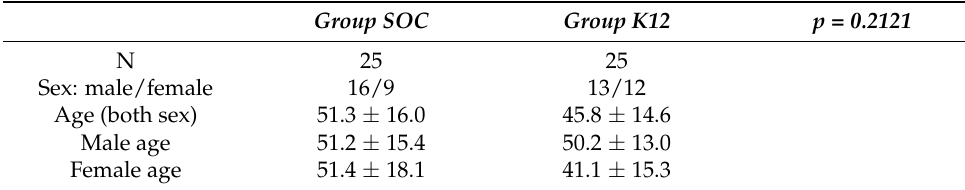
Table 1. Enrolled patients according to age, sex, and treatment. Group SOC Group K12 p = 0.2121